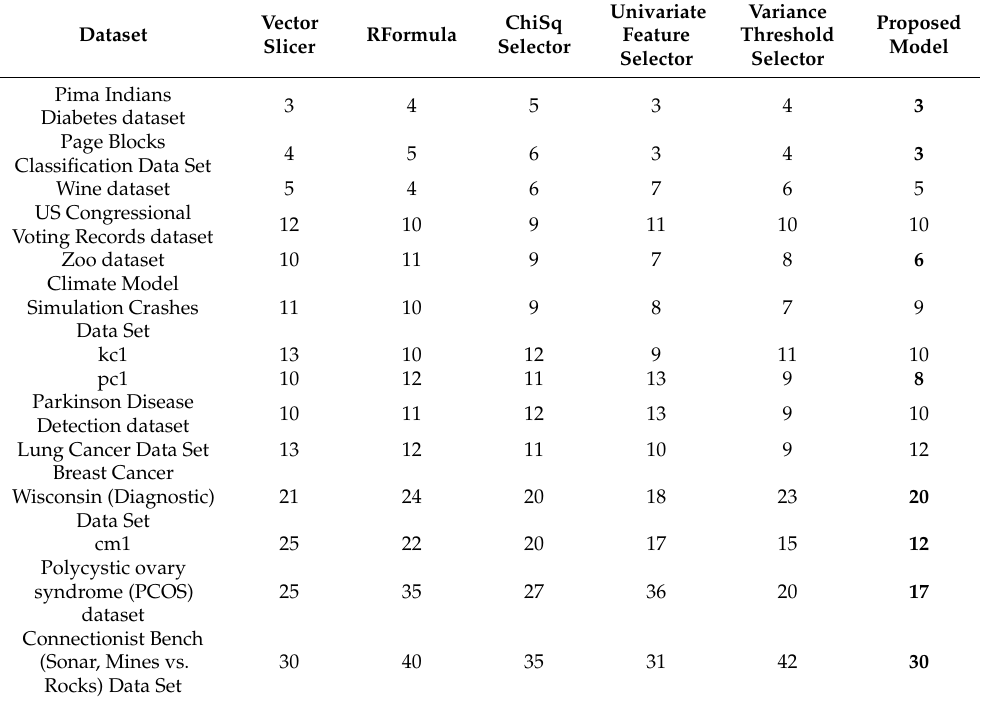
Table 2. Number of features selected by different feature selection